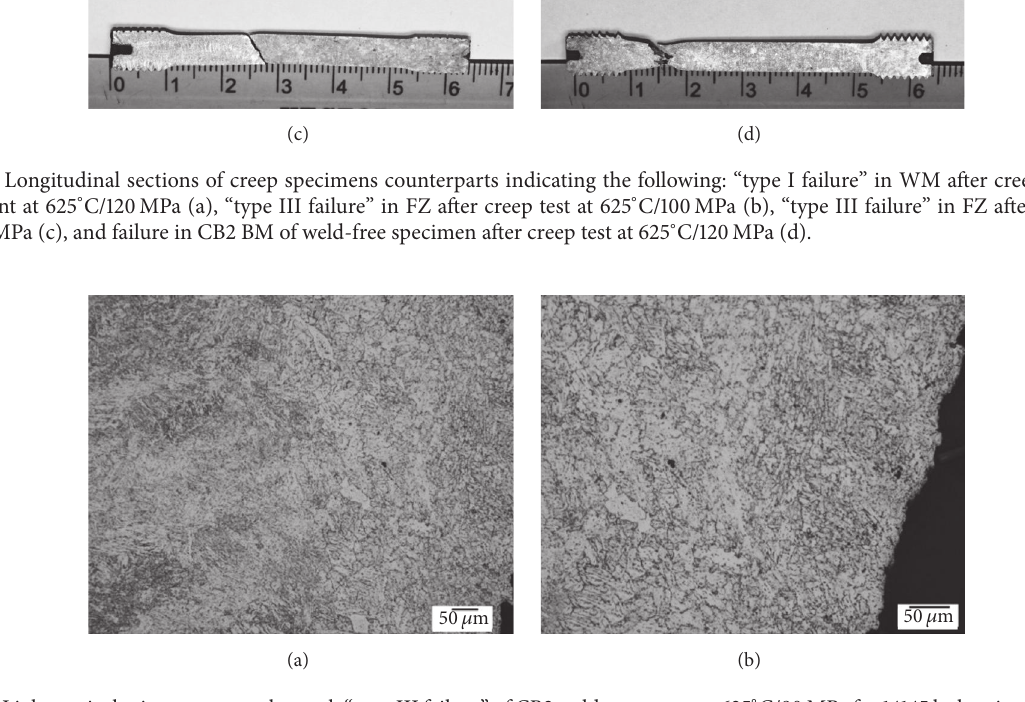
Figure 12: Light-optical microstructures beneath “type III failure” of CB2 weldment crept at 625 ∘ C/80MPa for 14145h showing the following: microstructural gradient between WM and FZ (a) and microstructure of FZ in detail (b).